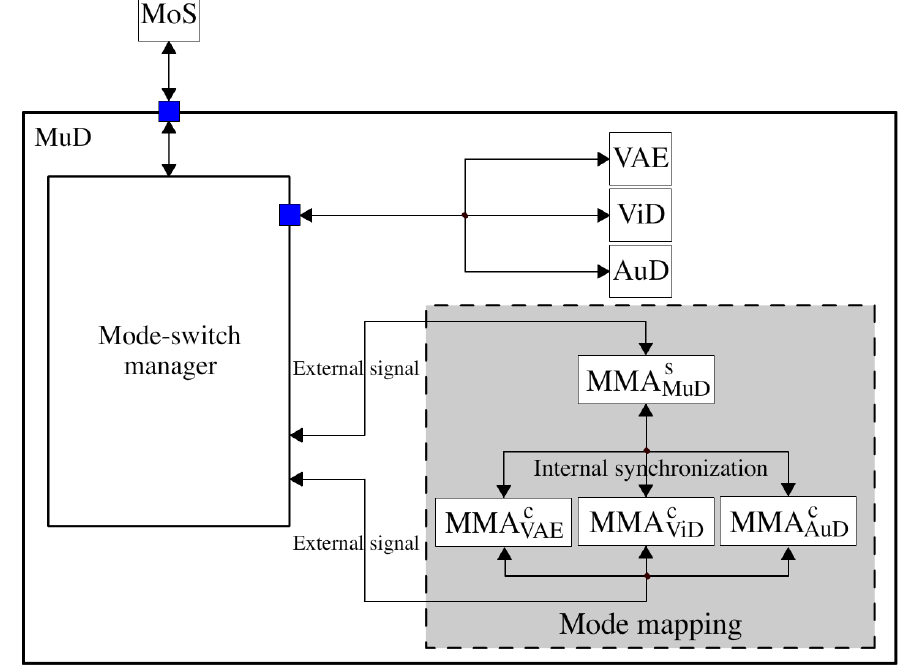
Figure 3. The role of the mode mapping of MuD at run-time. MMA, mode mapping